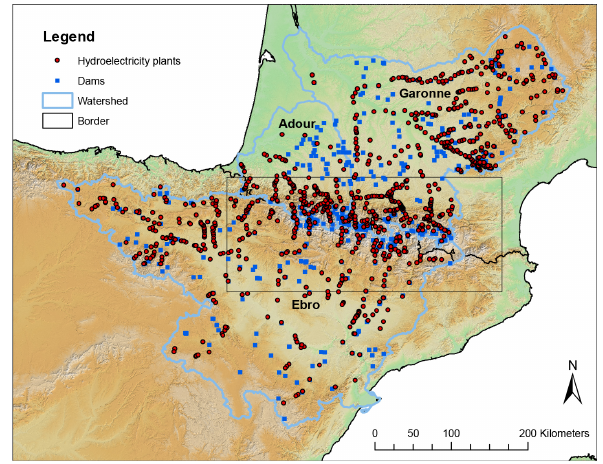
Figure 1. Shaded relief map of the study area and location of the snow monitoring stations used in this study (map projection Lambert-93). The rectangle is the area of interest used for re- mote sensing data (corner coordinates: upper left x = 320km, y = 6250km, lower right x = 680km, y = 6100km).